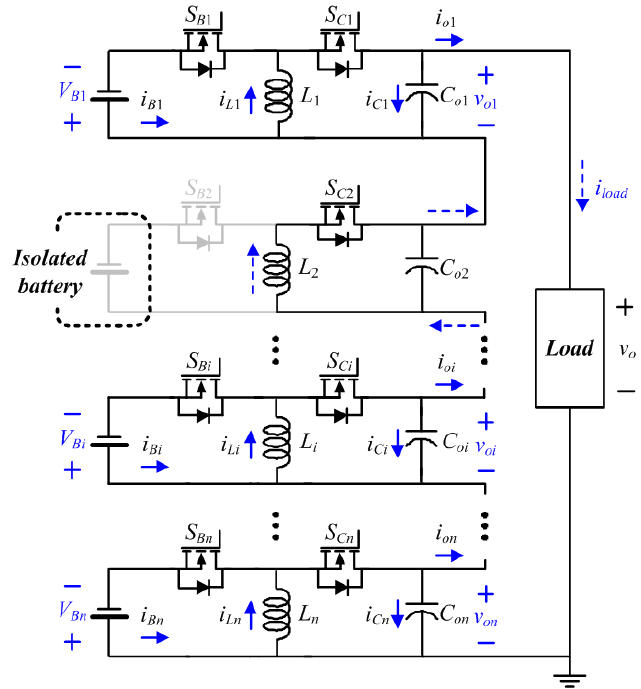
Figure 6. Current path of series BPMs with an isolated battery.